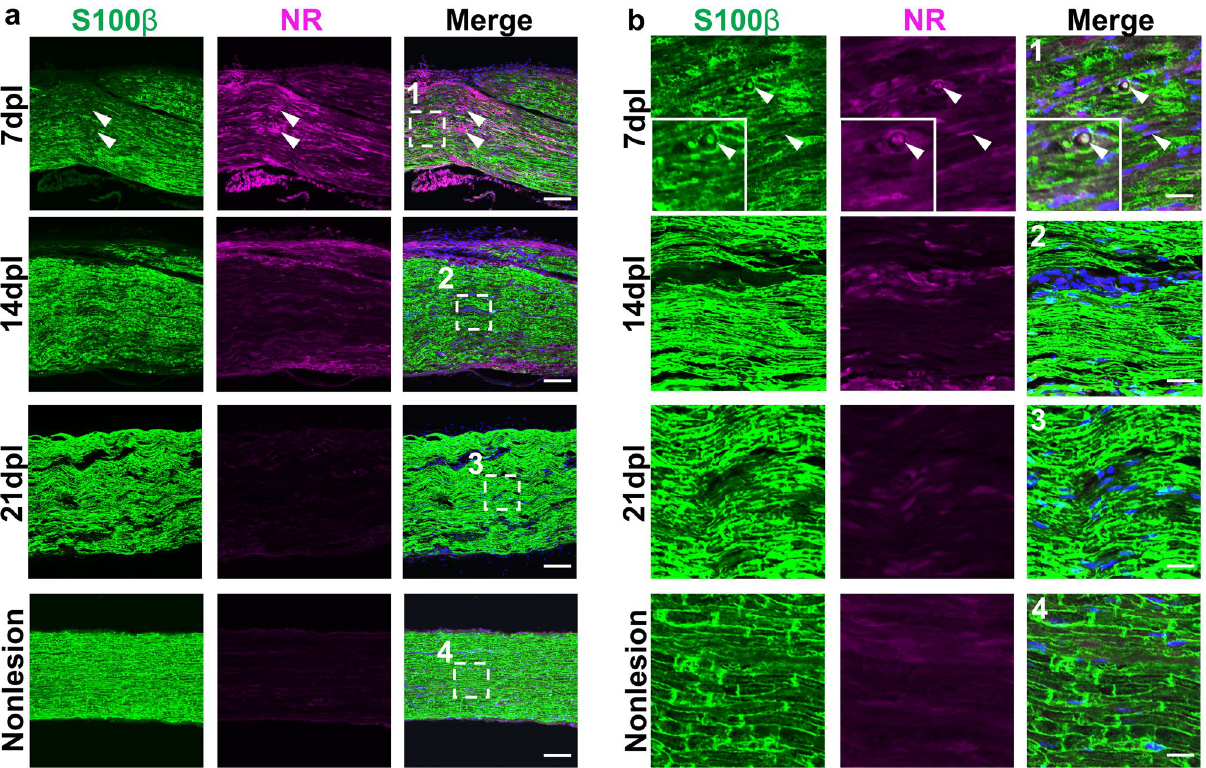
Figure 4. Neutral red (NR) colocalizes with Schwann cells in demyelinated lesions. ( a ) Representative confocal images of NR (magenta) and immunofluorescence staining for Schwann cell labeled with anti-S100β (green) in lysophosphatidylcholine (LPC)-treated nerves (7, 14, and 21 dpl) or non-lesioned nerves (n = 3 mice examined per timepoint). The demyelinated lesion is shown in 7 dpl image (arrowhead). ( b1–4 ) Enlarged images of ( a1–4 ) (white dotted square). Highly magnified images show NR signal were partially colocalized with S100β-positive cells (arrowhead). Insets Enlargements of double-positive cell. Nuclei were counterstained with Hoechst (blue). Scale bar, 50 µm ( a ) and 20 µm ( b